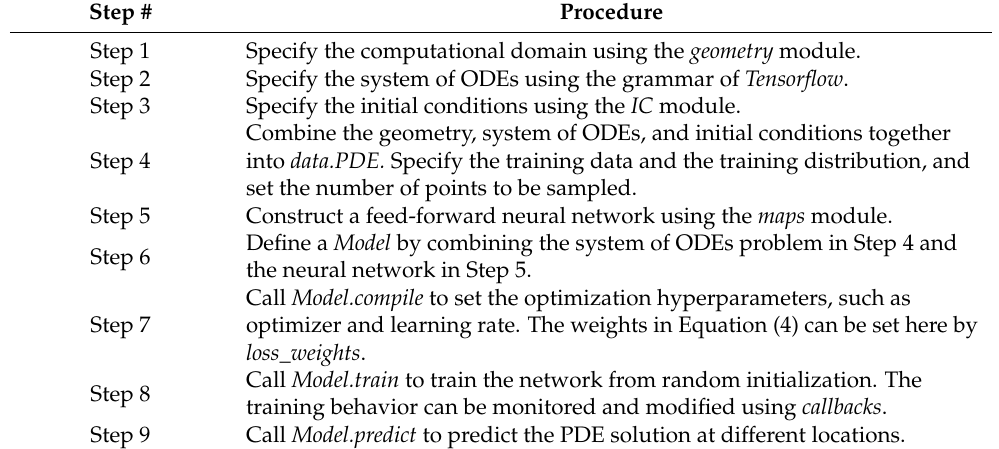
Table 3. Workflow for solving PKEs using PINNs in DeepXDE framework.